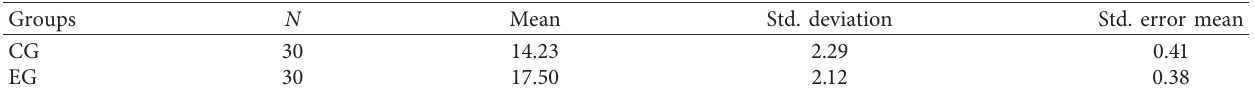
Table 3: Means and standard deviations of both groups on the reading comprehension posttest.